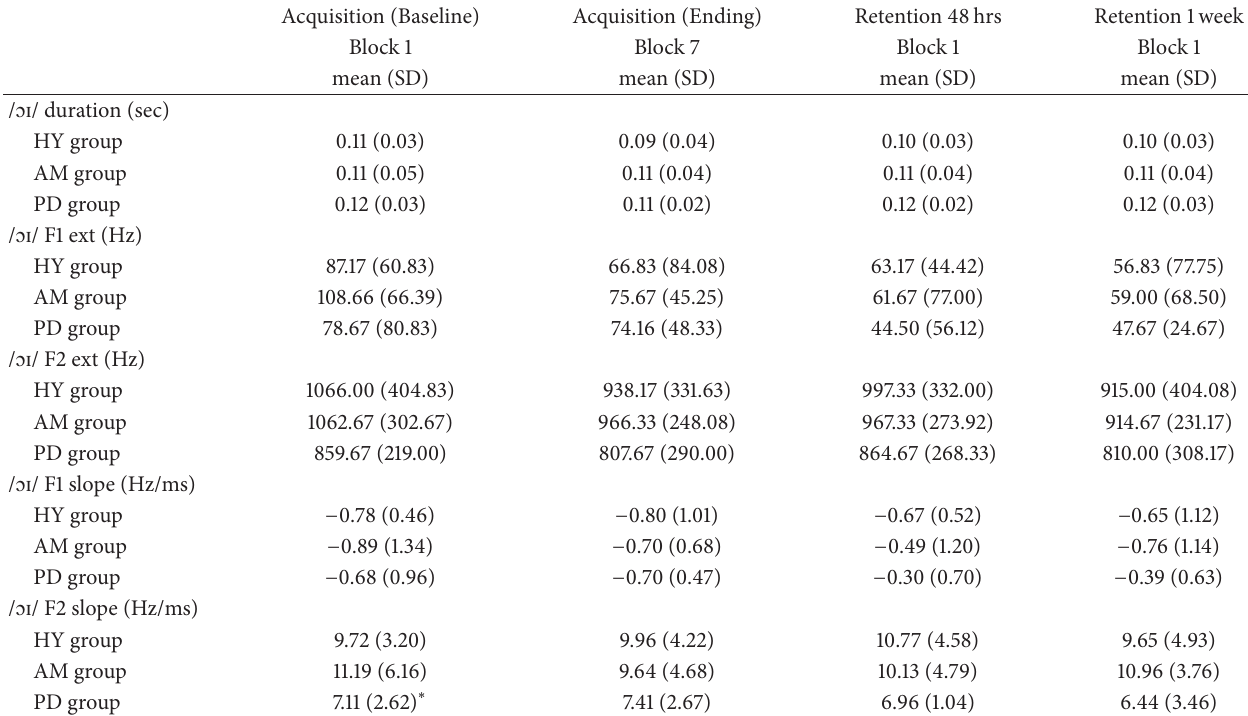
Table 3: Articulatory acoustic measures for / }0 / diphthong at acquisition and retention phases for each